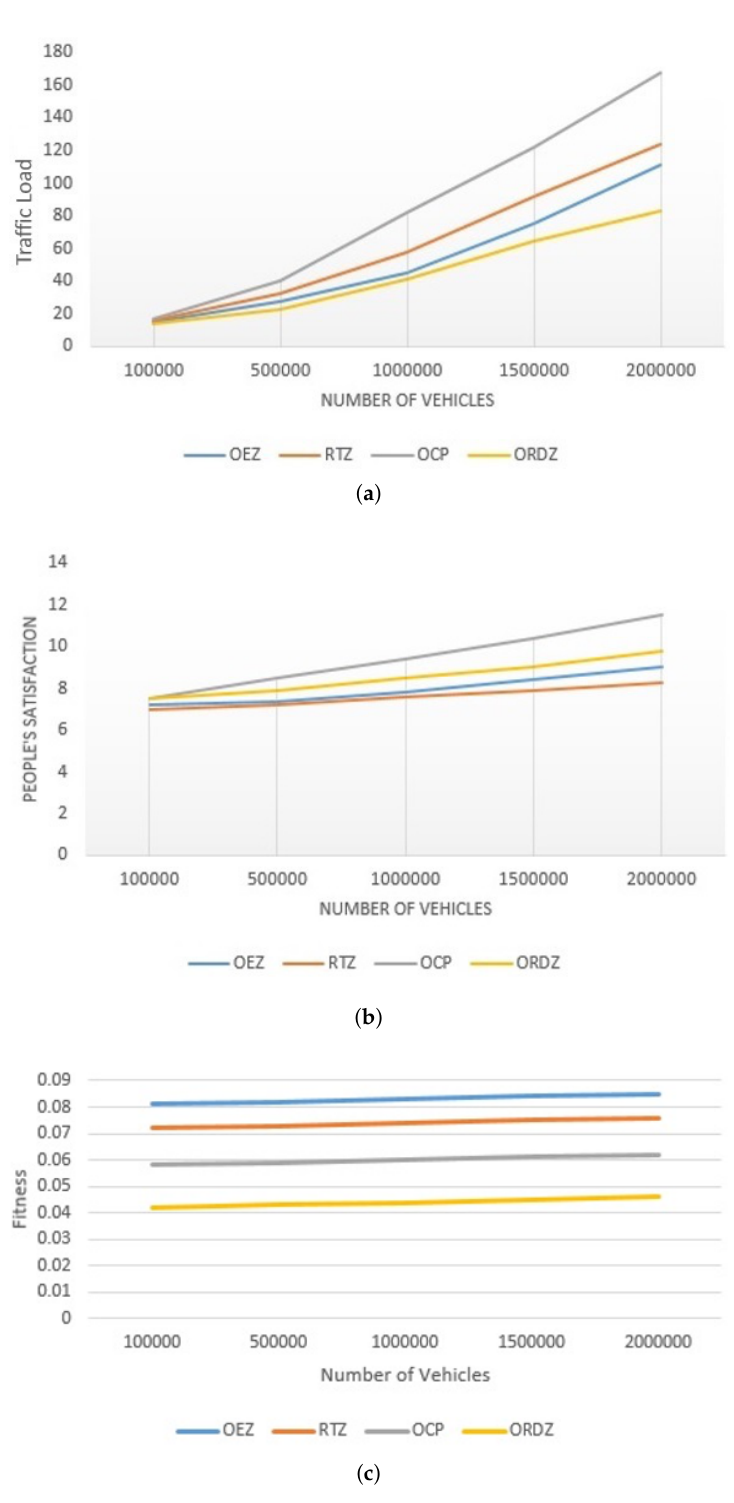
Figure 16. Comparison of different techniques based on: ( a ) impact of traffic load; ( b ) impact of citizen satisfaction; ( c ) fitness function for all